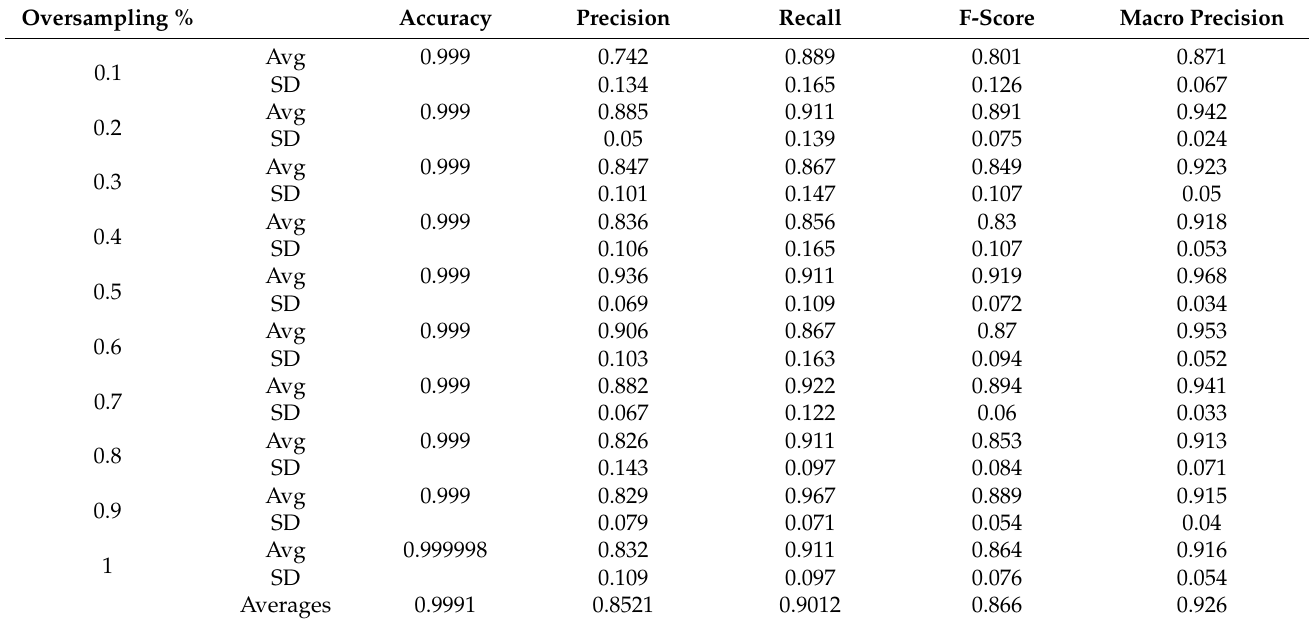
Table 11. UWF-ZeekData22: credential access—classification results for random undersampling before splitting.